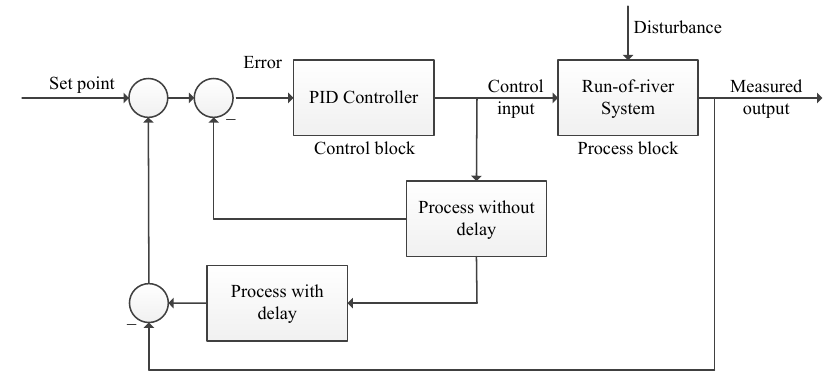
Figure 9: The control loop for the system (PID + Smith predictor).